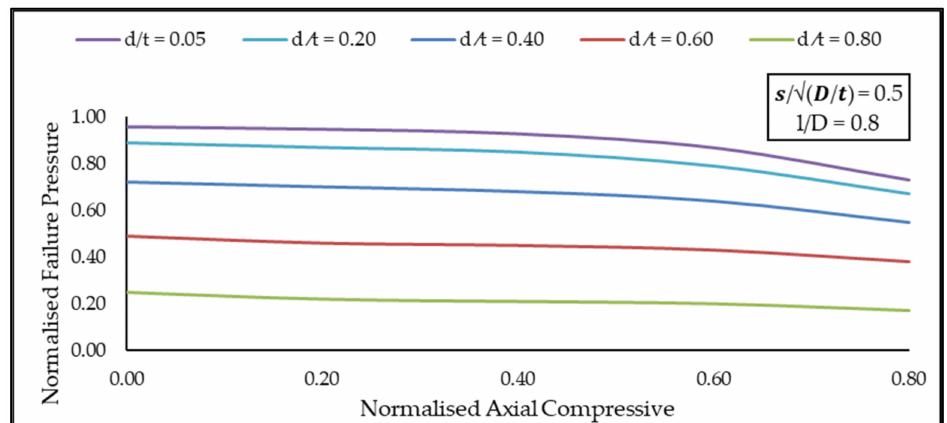
Figure 20. Normalized failure pressure predictions based on the empirical equation against various normalized axial compressive stresses for multiple normalized defect depths at constant normalized defect spacing of 0.5 and normalized defect length of